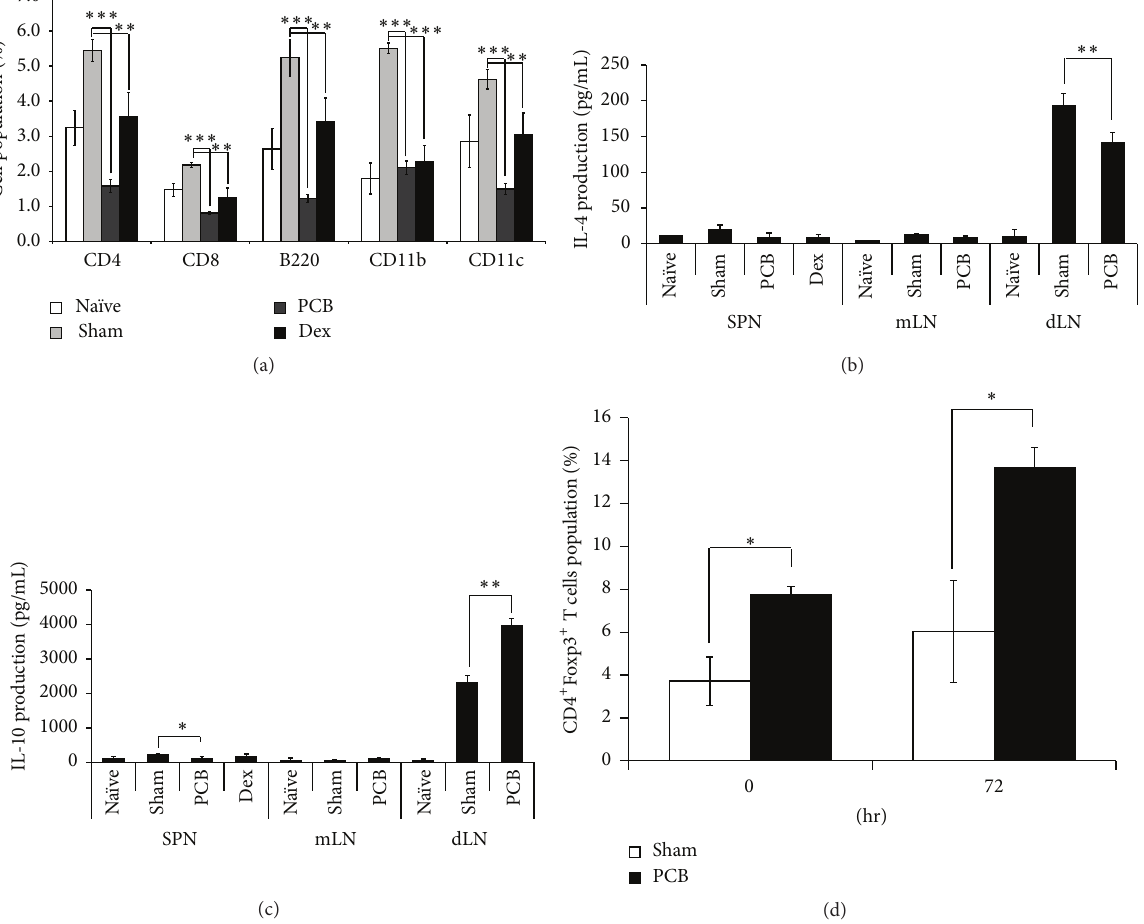
010002000300040005000 ∗ Figure 3: PCB extract suppressed infiltrated immune cell and Th2-related cytokine via Foxp3 regulation in a mouse model of AD. (a) For analyzed immune cells in ear, ear tissues were isolated single cells. The cells were stained with with anti-CD4 (FITC), anti-CD8 (APC/Cy7), anti-CD11c (PE), anti-CD11b (APC), and anti CD45R (PerCP/Cy5.5). These surface molecules of immune cells were measured by flow cytometry. To measure cytokines, the cells isolated from dLNs were restimulated with 100 𝜇 g/mL HDM extract and cultured for 72 h. IL- 4 (b) and IL-10 (c) were detected by ELISA. (d) To evaluate population of CD4 + Foxp3 + T cells, the cells isolated from dLNs were cultured with PMA (50 ng/mL) and Ionomycin (250 ng/mL). After staining with CD4 and Foxp3, the population of CD4 + Foxp3 + T cells was analyzed by flow cytometry at 0h and 72 h. Each value is shown as mean ± SD ( 𝑛 = 3 ). ∗ 𝑃 < 0.05 , ∗∗ 𝑃 < 0.01 , and ∗∗∗ 𝑃 < 0.001 compared with sham group. Data were analyzed using ANOVA followed by F -protected Fisher’s least significant difference